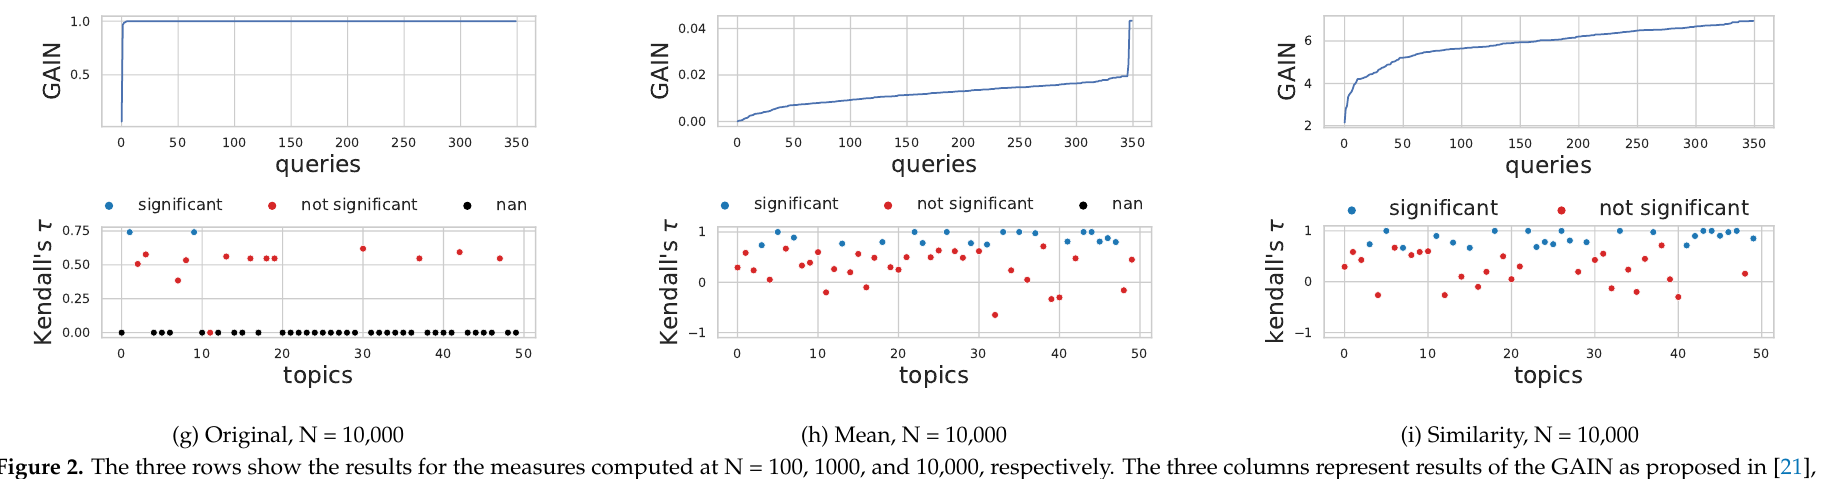
Figure 2. The three rows show the results for the measures computed at N = 100, 1000, and 10,000, respectively. The three columns represent results of the GAIN as proposed in [21], the mean aggregation and the similarity-based aggregation strategy. Each subfigure shows (top) the distribution of the GAIN, ordered increasingly, of the 350 queries and (bottom) correlation between the reformulations ordered by predicted GAIN (or similarity) and the reformulations ordered by the true